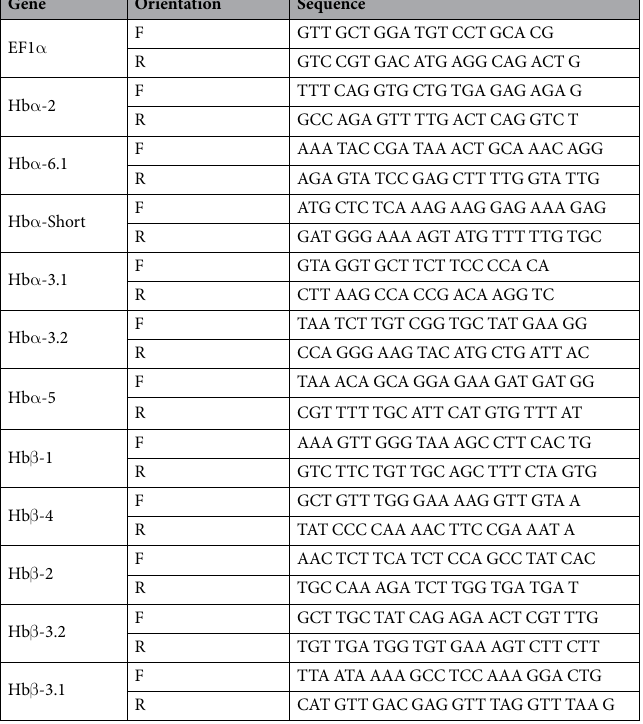
Table 3. List of real-time PCR primers used for Hb subunit gene expression analysis. All sequences listed 5 ′ to 3 ′ with the reverse primer sequences listed as the reverse compliment of the gene